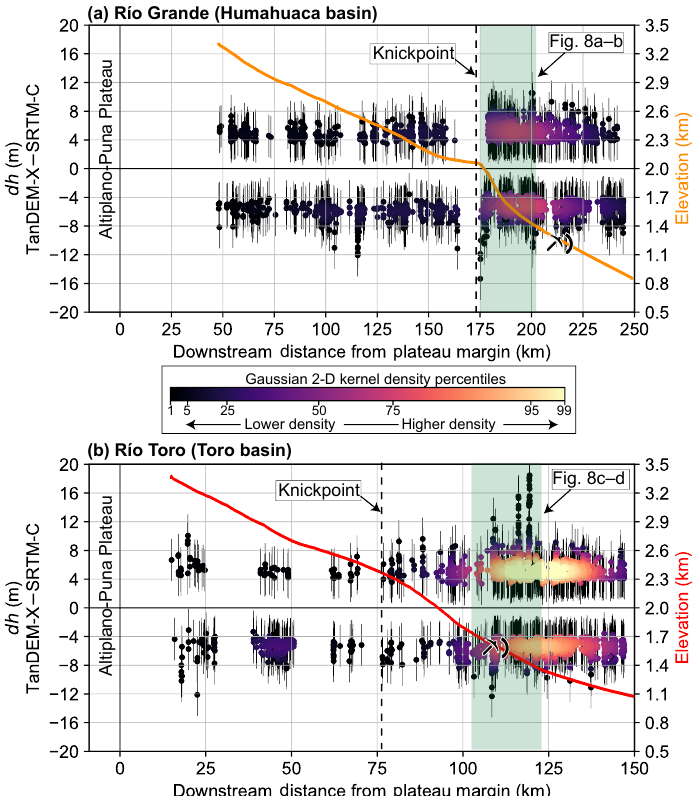
Figure 7. Longitudinal profiles of (a) Río Grande and (b) Río Toro overlain with the point cloud of the potential dh signal (pixels outside of the range of expected noise). Error bars are RMSE from low-slope ( < 5 ◦ ) terrain outside of the channel area. Each dh point cloud is colored by probability density from a Gaussian 2-D KDE to show the denser (warmer) versus sparser (cooler) reaches. The KDE is scaled over all measurements from both channels and relative percentiles of the full distribution are used to highlight denser zones, particularly in (b) Río Toro. Note the x -axis range is 100km greater for the longer Río Grande, despite the same axis scaling. The color scheme for elevation profiles on right axes matches the map-view color of each channel in Fig. 1b. The knickpoint in Río Grande is caused by the large Del Medio fan (Savi et al., 2016), whereas the origin in Río Toro is tectonic, caused by the Gólgota Fault (Marrett et al., 1994; Hilley and Strecker, 2005). In both cases, the majority of the dh signal appears downstream of the knickpoint. The map view of green highlighted regions is shown in Fig.